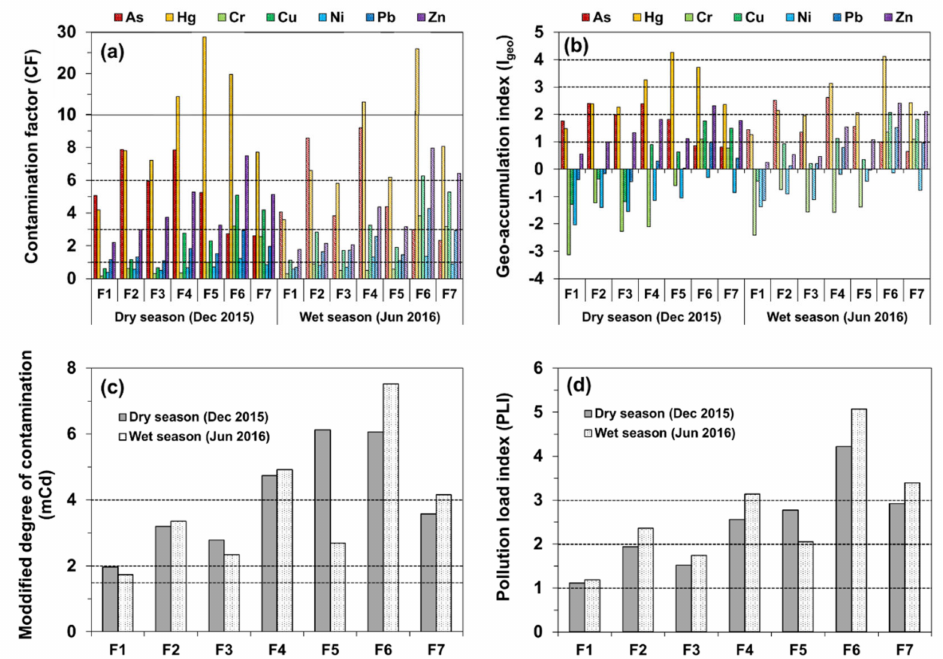
Figure 3. ( a ) Contamination factor (CF), ( b ) geo-accumulation index (I geo ), ( c ) modified degree of contamination (mCd), and ( d ) pollution load index (PLI) for heavy metals (As, Hg, Cr, Cu, Ni,